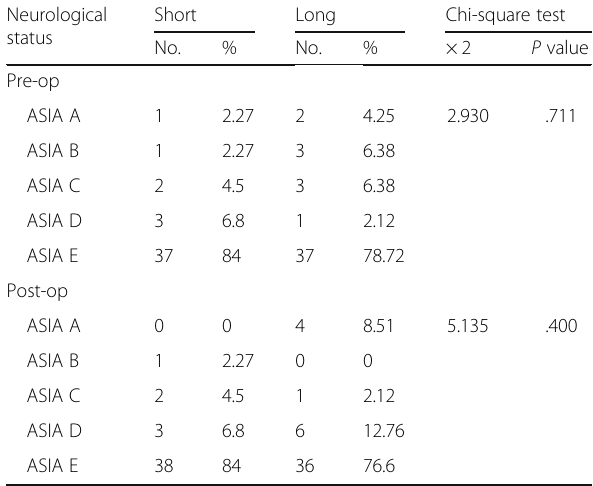
Three patients in the short-segment fixation group had complications; one patient had CSF leakage, and two pa- tients had superficial wound infection. All of them were treated conservatively. Five patients in the long segment group had different complications; one patient has a pullout of the upper screws, and two patients had a fractured rod. All of these three patients had a redo surgery.